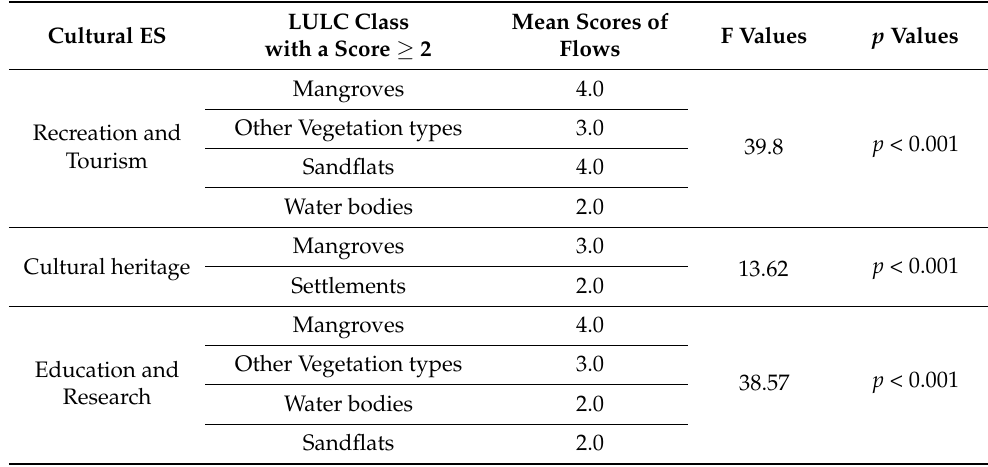
Table 6. Summary statistics of the one-way ANOVA-test for the assessment of flow cultural ES from the LULC with high scores: n = 80 for Ungwana bay,